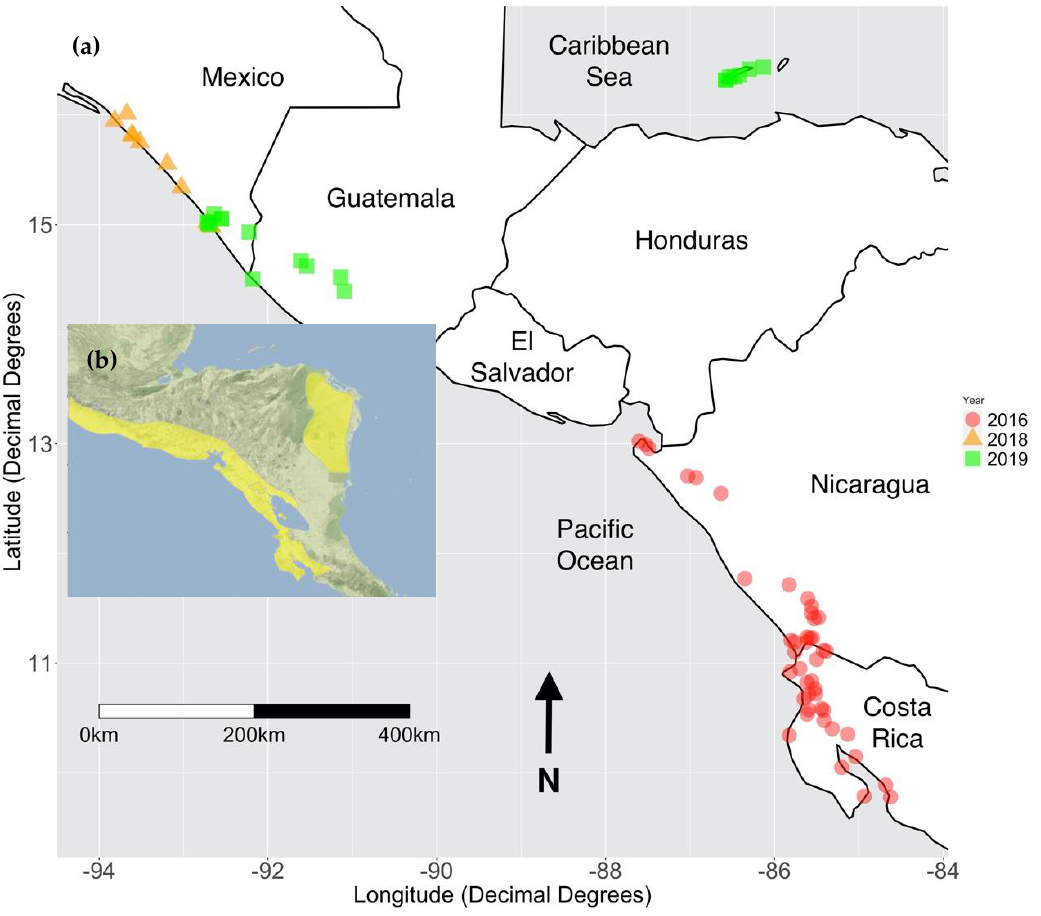
Figure 1. ( a ) A map of all sites sampled during 2018 and 2019. Sites from the Wright et al. study [13] conducted in 2016 are also included. The color and shape of each point corresponds to the year the site was sampled. ( b ) A species range polygon for the yellow-naped amazon provided by BirdLife [22].